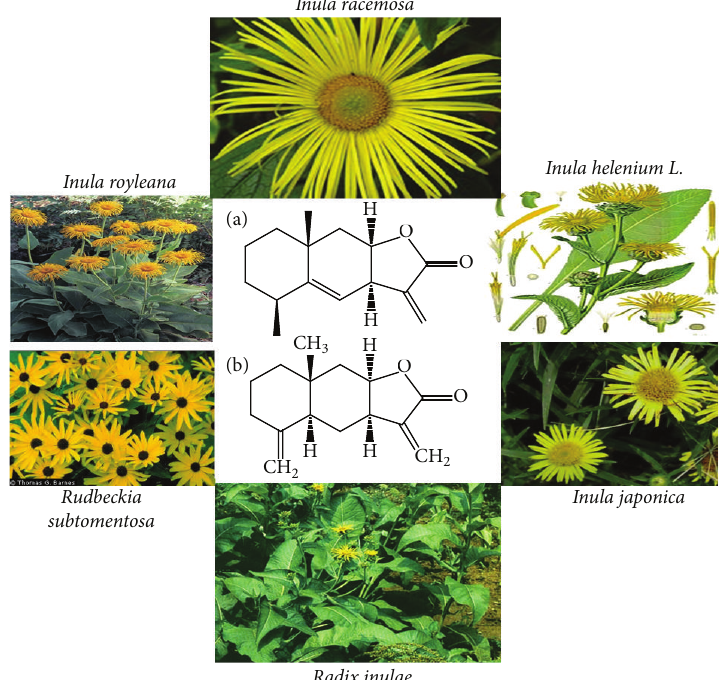
Figure 1: Chemical structure of alantolactone (a) and isoalantolactone (b) and natural